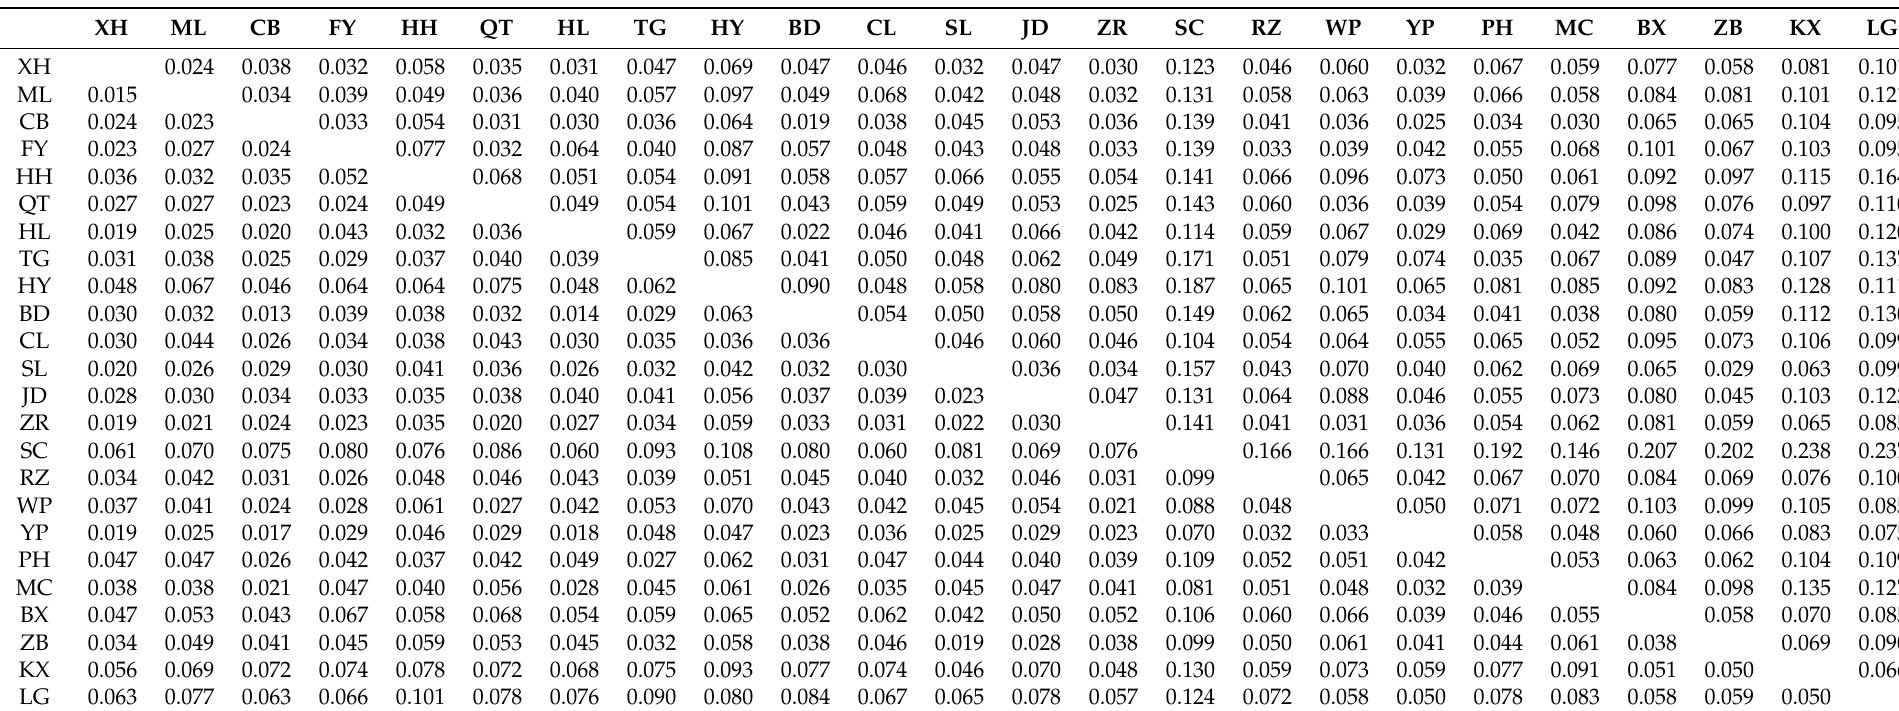
Table 4. Genetic differentiation F ST (upper right) and D (cid:48) (lower left) among 24 populations of Spodoptera litura